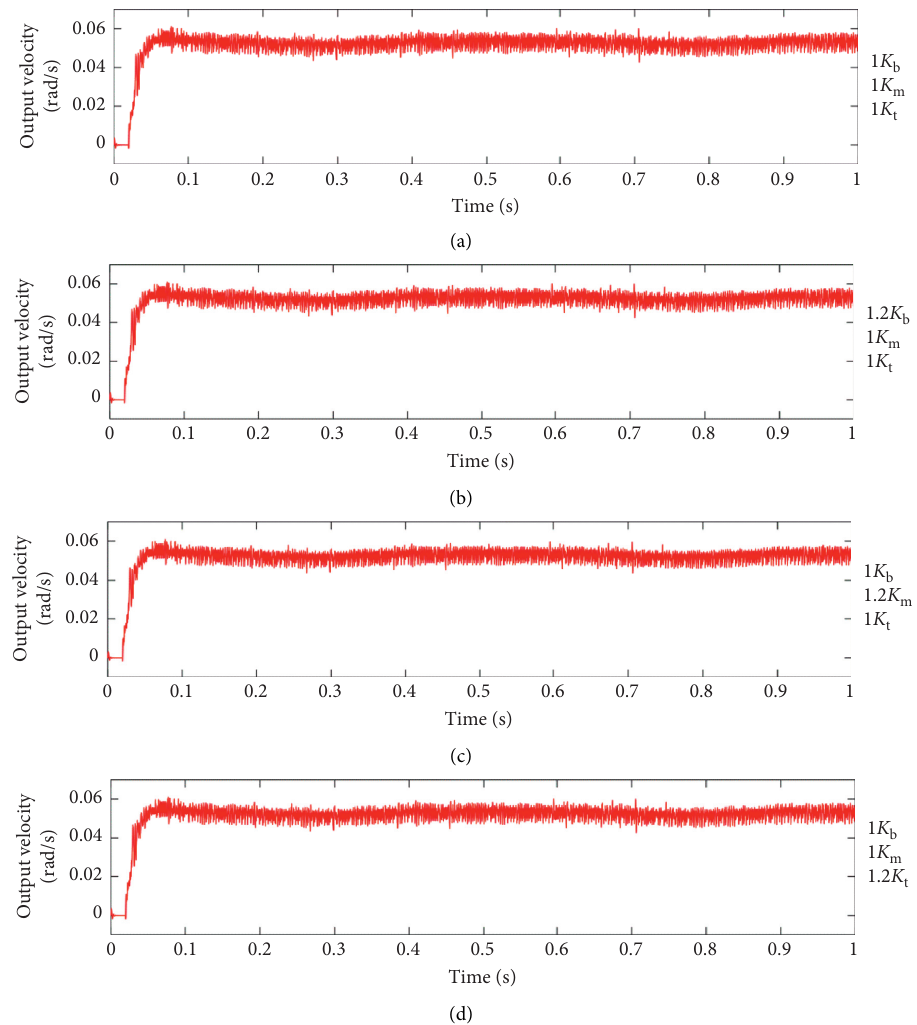
Figure 11: Velocity step responses of different stiffness at 60rpm.